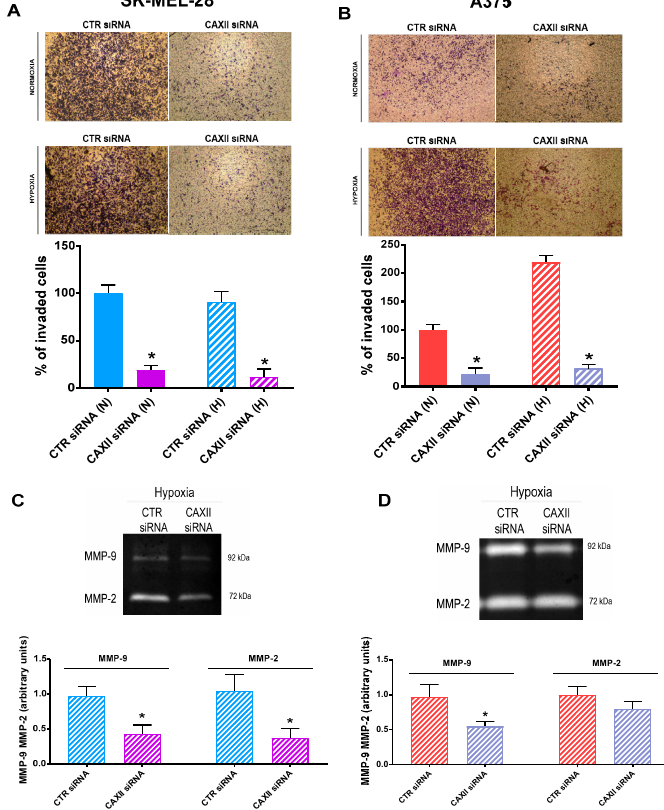
Figure 8. CAXII transient knockdown resulted in decreased cell invasion and MMP-2/ MMP-9 ac- tivity. Cell invasion measured by modified Boyden chamber assay in SK-MEL-28 ( A ) and A375 ( B ) cells silenced with CAXII siRNA under normoxic (N) and hypoxic (H) conditions. Zymogram assays in hypoxic SK-MEL-28 ( C ) and A375 ( D ) cells. Pictures and blots are representative of three inde- pendent experiments. Means ± SEM are presented. (n = 3; * p ≤ 0.05 indicates statistically significant difference).